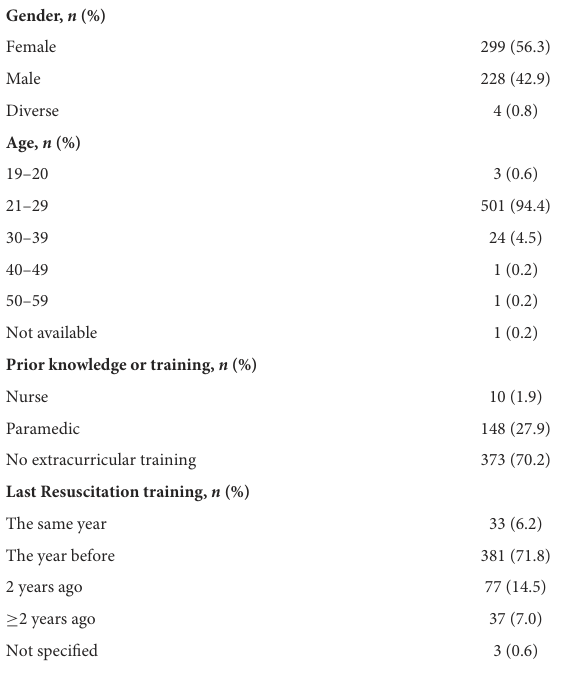
TABLE 2 Median percentage of correctly answered multiple-choice test questions of the multiple-choice test carried out before (MC_pre) and after (MC_post) the Moodle ® (Modular Object-Oriented Dynamic Learning Environment) course.